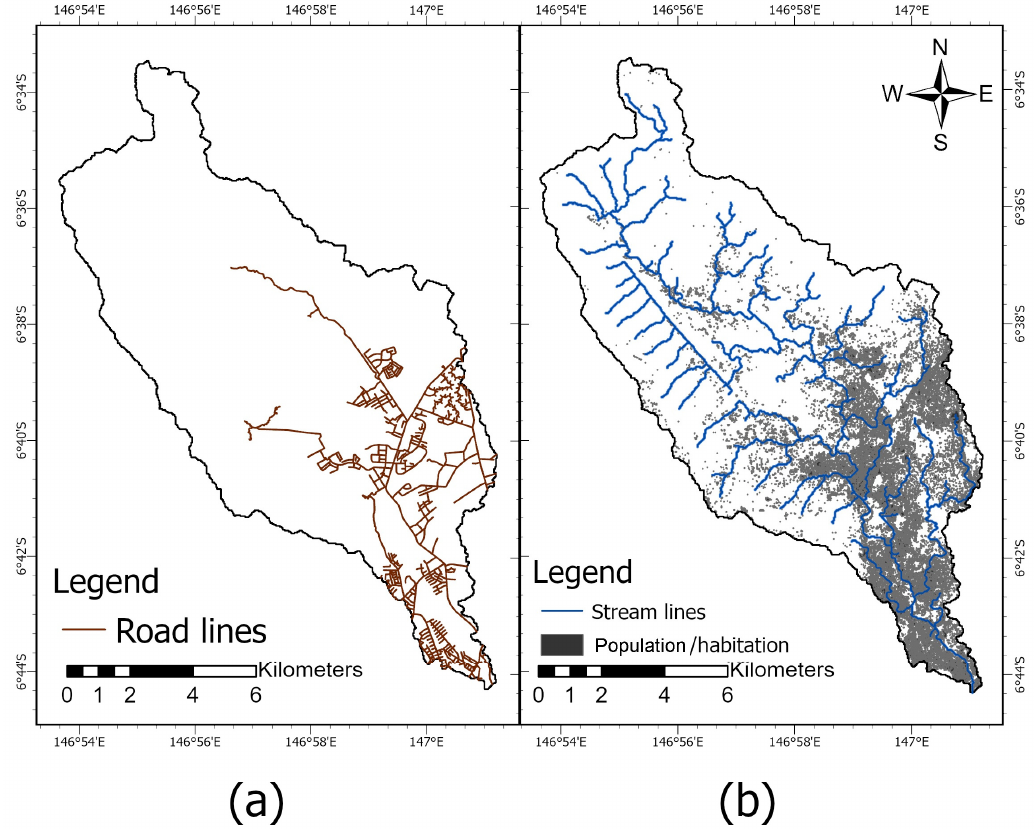
Figure 7. Shapefile input layers and result of grid transformation ( a ) road line vectors and ( b ) population/habitation